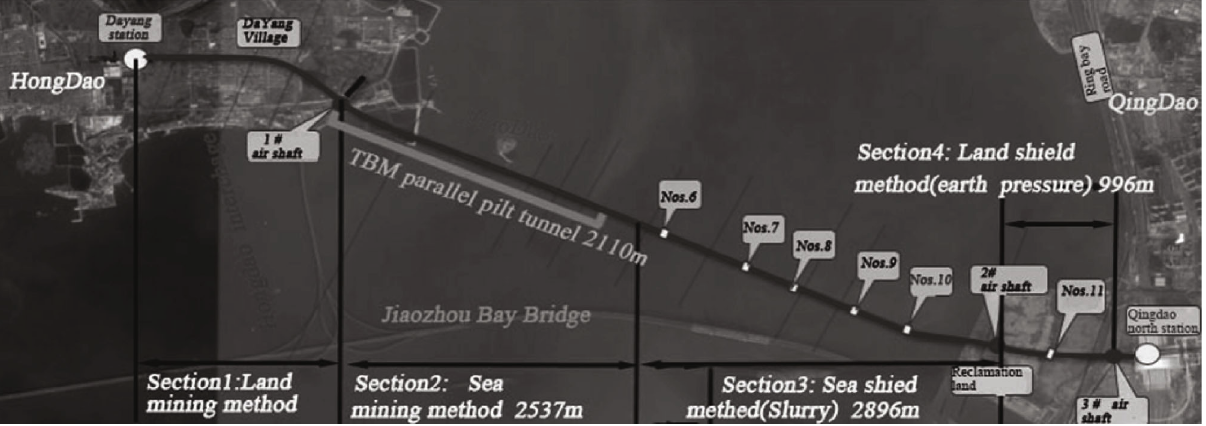
Figure 3: Schematic of the interval.